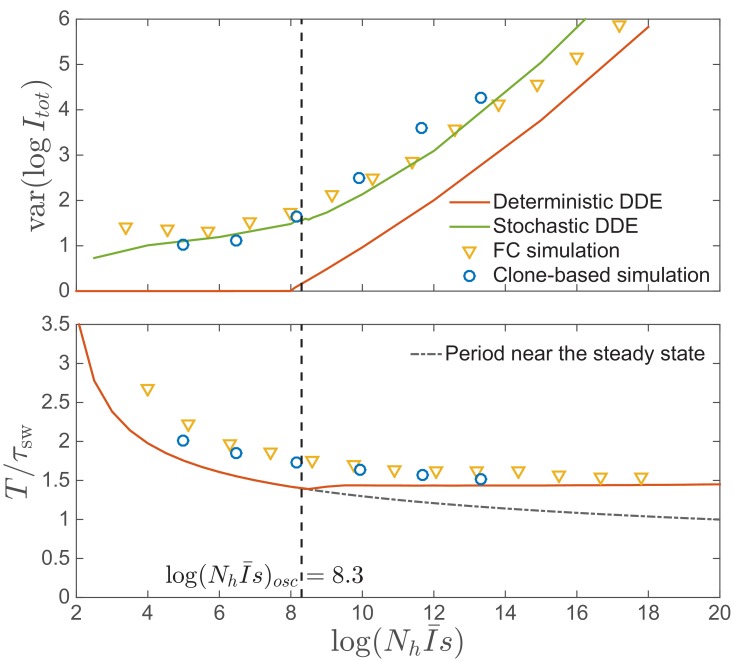
Amplitude and time scale of oscillations.Top: Amplitude of epidemic circulations in logarithm of total prevalence. The amplitude predicted in the fitness class-based (FC) simulation is consistent with the clone-based simulation, bounded from below by the amplitude in the deterministic differential-delay approximation (DDE), which sets on at the spontaneous oscillation threshold log(NhI¯s)o⁢s⁢c=8.3, indicated by the dashed line. When the noise is properly considered as in Equation (15), the amplitude can also be predicted from the stochastic differential-delay equations (DDE). Bottom: Period of epidemic oscillation, also bounded below by the limit cycle period of the deterministic DDE.